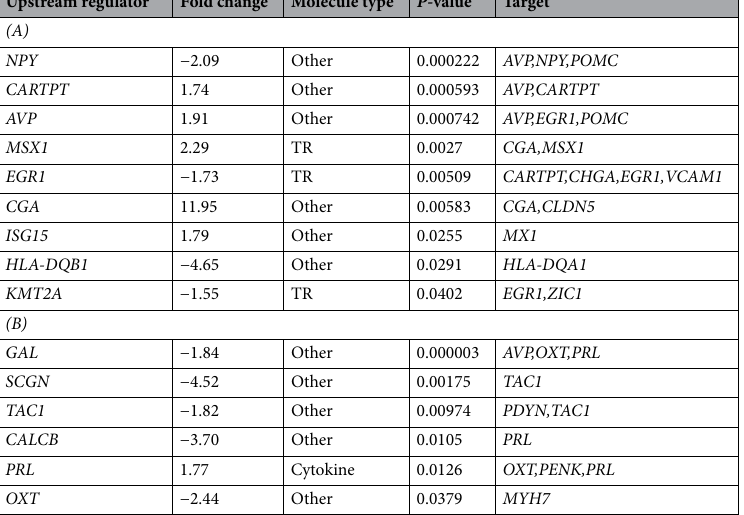
Table S8. Finally, three networks were derived from the list of DEGs in this tissue, the biological functions of which were: behaviour, dermatological diseases and conditions, neurological disease (19 DEGs included within the network), cancer, organismal injury and abnormalities, respiratory disease (14 DEGs), and cell signalling, nucleic acid metabolism, small molecule biochemistry (6 DEGs). Results from the conventional downstream analysis approaches described above give relevant insight into the potential effects of the induced alterations in gene expression. However, they provide only limited clues to the underlying causes that provoke such effects. Therefore, we also carried out an upstream analysis enabling a causal interpretation of the observed expression changes. Six potential upstream regulators, included in the list of DEGs, that controlled the expression of other DEGs (target genes) found in the remaining hypothalamus are